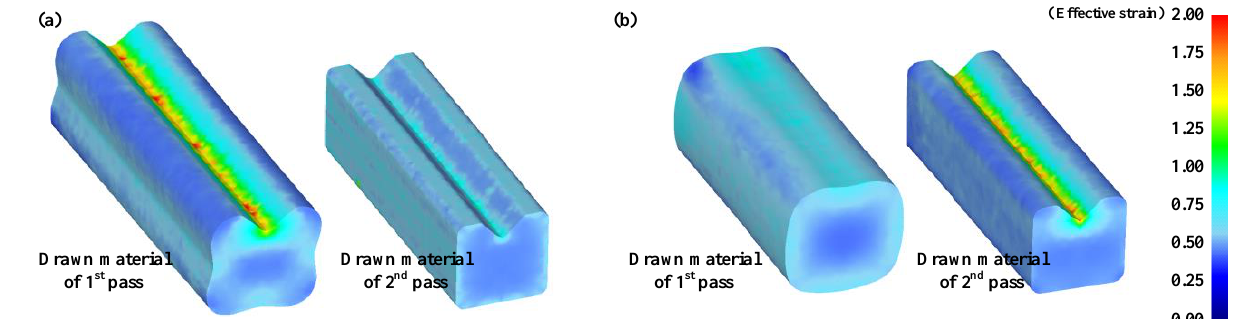
Figure 11. FE model of shape drawing process for the cross-roller guide: ( a ) ERV method; ( b ) equipotential line method.